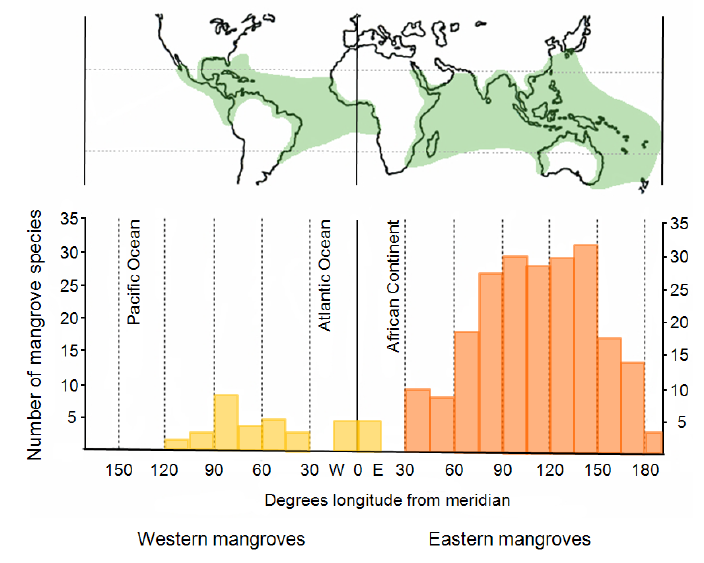
Figure 1. Generalized global distribution of mangroves and diversity of mangrove species per 15° of longitude (Source: adapted from Tomlinson 1986